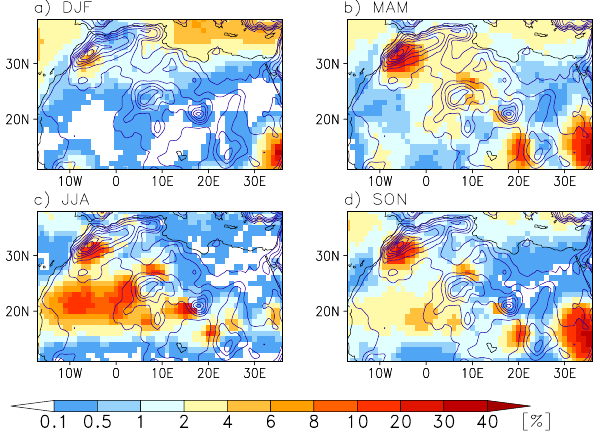
Figure 2. Track density of all identified depressions. Climatol- ogy of the occurrence frequency of depressions for (a) December– February, (b) March–May, (c) June–August and (d) September– November for 1989–2008 based on the depression centre defined by the outermost closed contour in the geopotential height at 925hPa from the tracking algorithm (Sect. 2.1). Contours show the orogra- phy in steps of